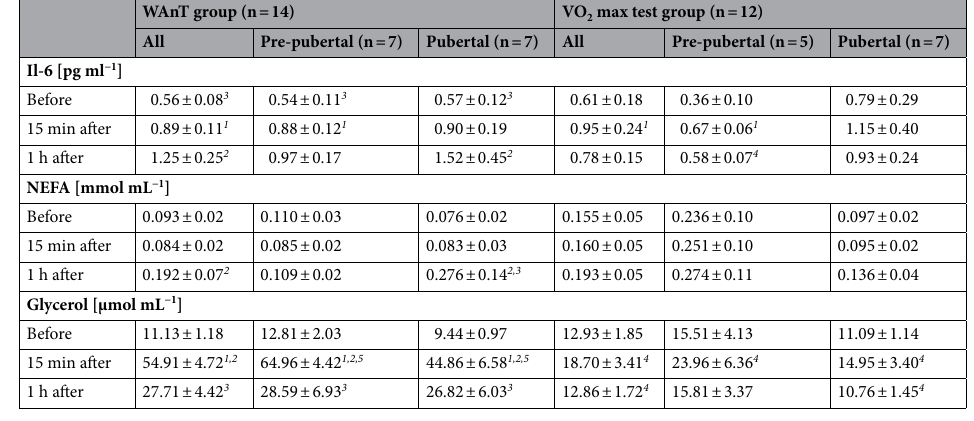
Table 2. Il-6, NEFA and glycerol level at baseline, 15 min and 1 h after the tests. 1 p < 0.05 between results before and 15 min after in the same group. 2 p < 0.05 between 15 min after to 1 h after in the same group. 3 p < 0.05 between before and 1 h after in the same group. 4 p < 0.05 between WAnT at the same time point in the same group. 5 p < 0.05 between pubertal and pre-pubertal groups at the same time points in the same tests.